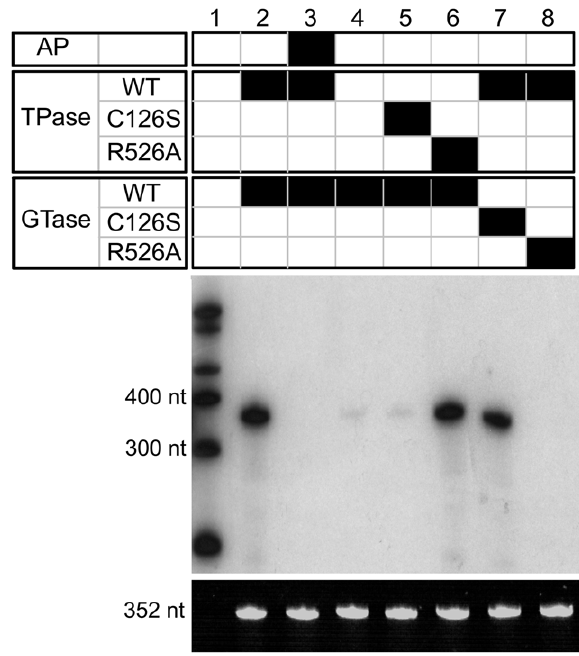
Figure 5. RNA capping activity of recombinant TvCE. Capping activity was detected in a two-step reaction, monitoring both TPase and GTase activities, using [ a - 32 P]GTP and a 352 nt RNA substrate. Wild-type TvCE (WT), a TPase-inactive mutant (C126S) and a GTase-inactive mutant (R526S) were tested in the two-step reaction using various combinations as indicated in the black filled squares (top panel). A negative control reaction using the RNA substrate dephosphorylated by alkaline phosphatase prior to capping was included as indicated (AP). The final product was split equally and loaded on two polyacrylamide gels that were subsequently analyzed by autoradiography (middle panel) or ethidium bromide staining (bottom panel). Arrows denote molecular weights of radiolabeled RNA markers (Century Marker Plus, Ambion) and the RNA substrate. and then 5 9 -end labeled using T4 polynucleotide kinase. These